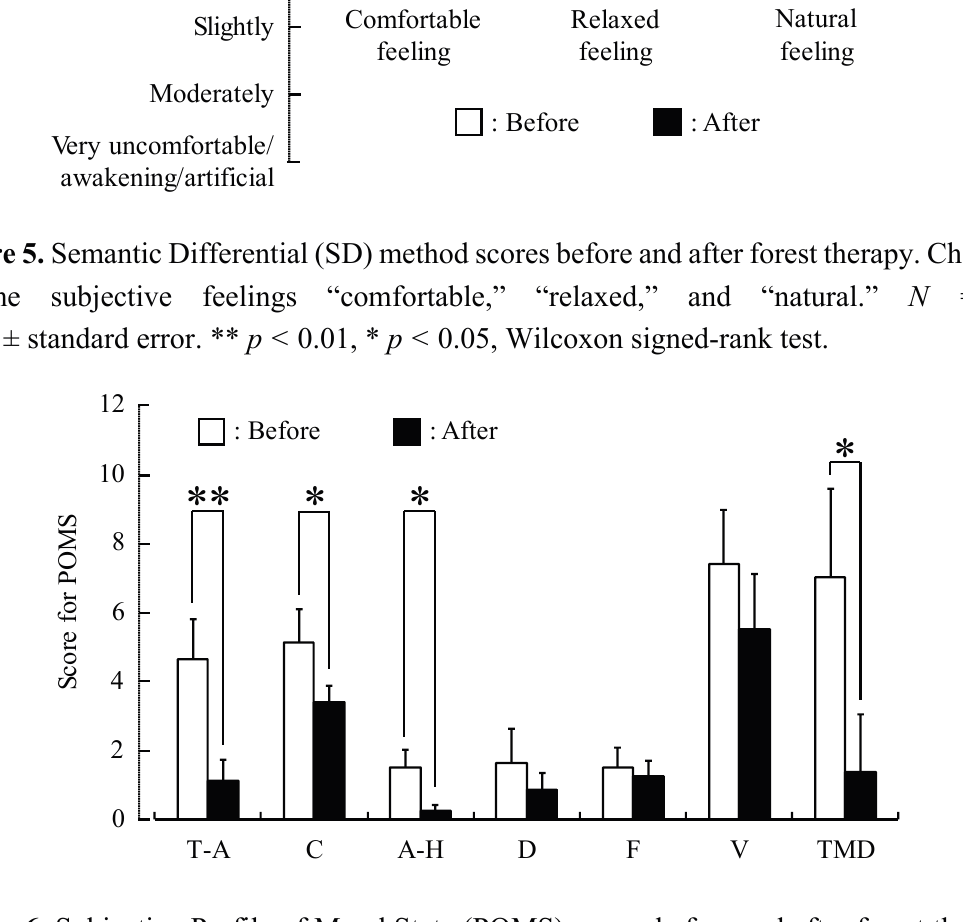
Figure 6. Subjective Profile of Mood State (POMS) scores before and after forest therapy. T-A, tension-anxiety; C, confusion; A-H, anger-hostility; D, depression; F, fatigue; V, vigor; TMD, Total Mood Disturbance. N = 8, mean ± standard error. ** p < 0.01, * p < 0.05, Wilcoxon signed-rank